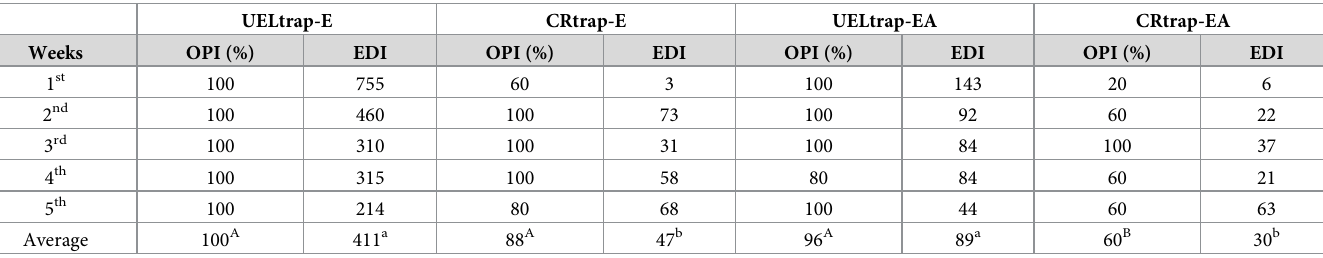
Table 6. Ovitraps positivity index (OPI) and egg density index (EDI) obtained per week in each trap from January to February 2018 in Manaus, Amazonas, Brazil.